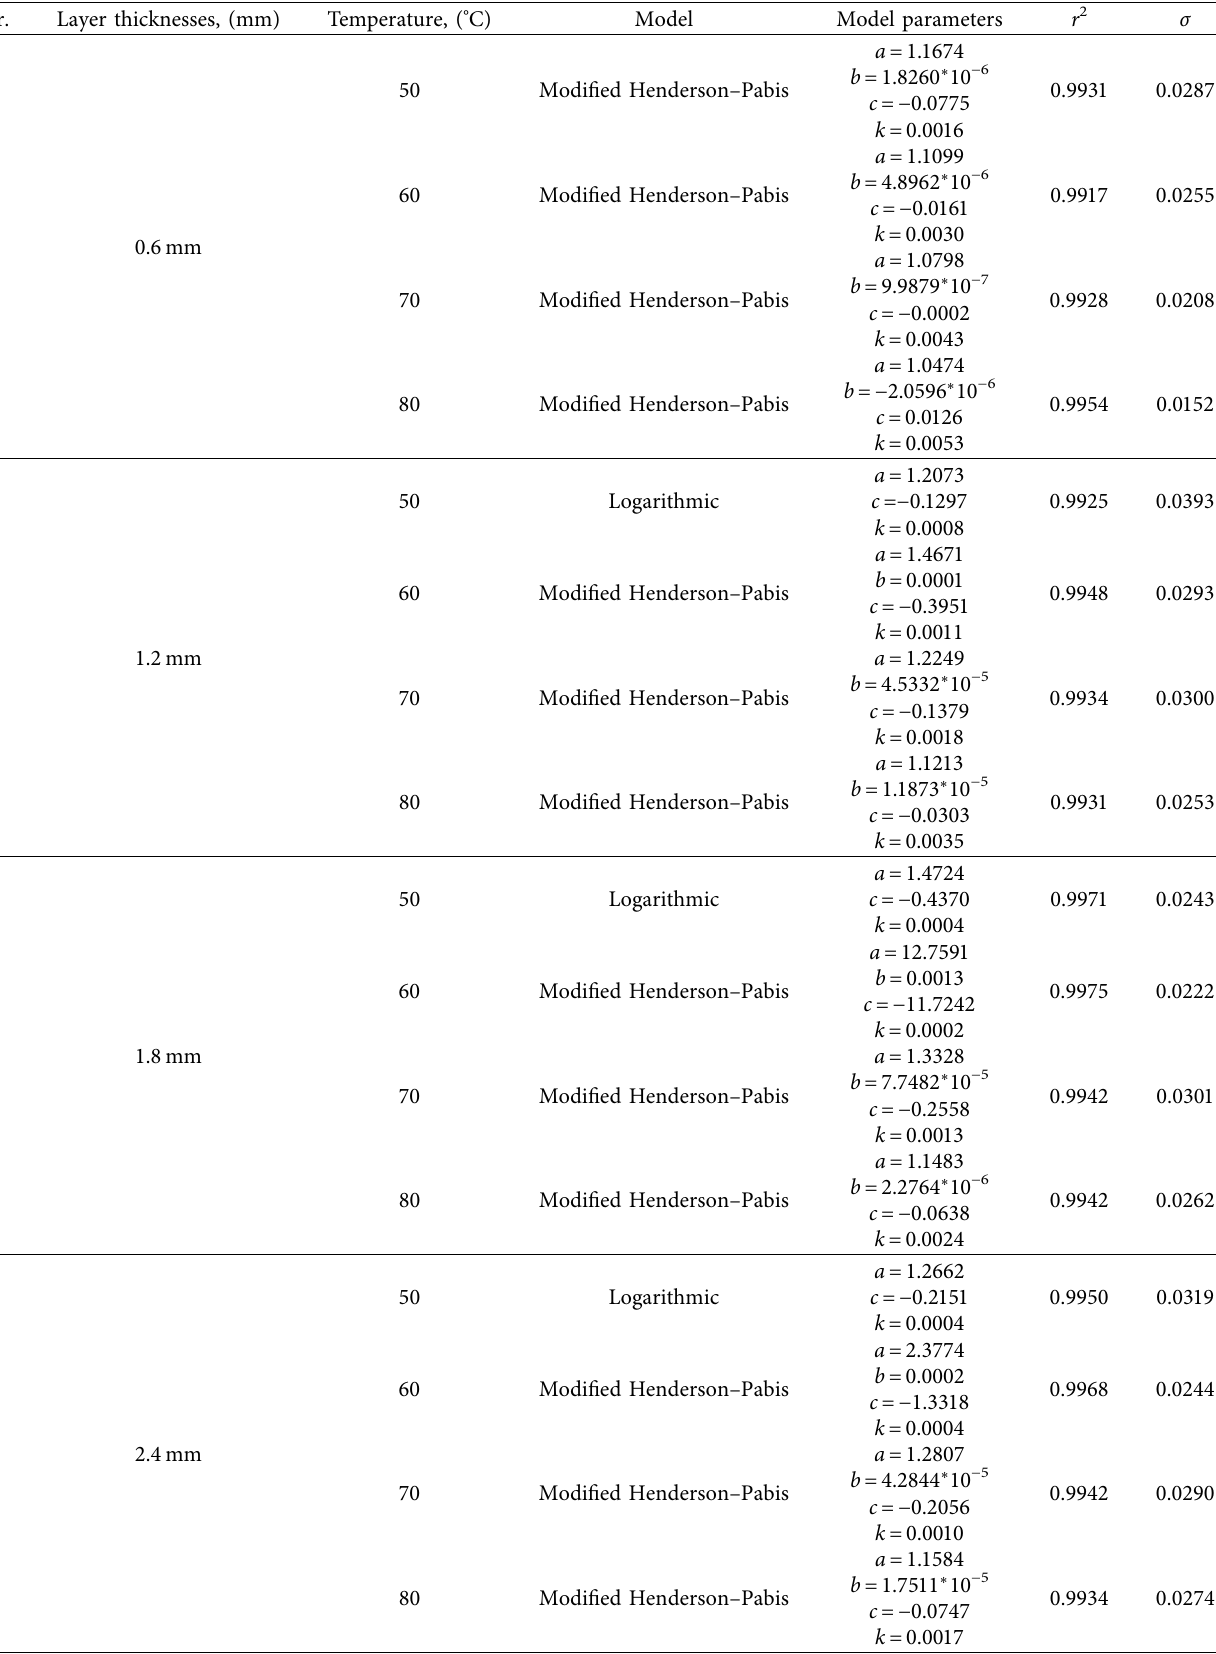
Table 3: Values of the coefficient in the modified Henderson–Pabis model and its performance.